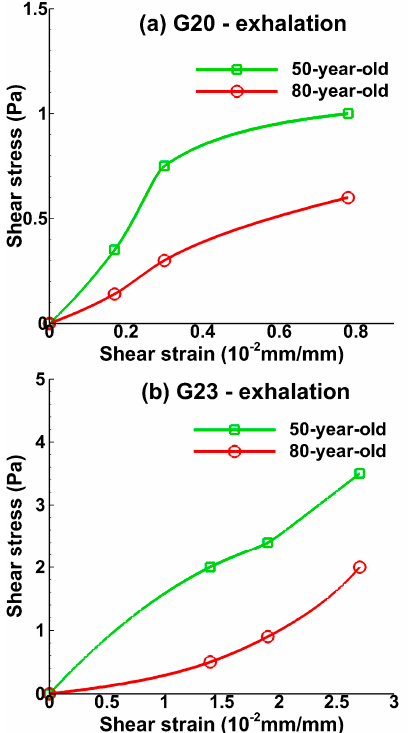
Figure 7. Relationship between shear strain and shear stress during mid ‐ point of exhalation (t = 1.2 s) at ( a ) the bronchiole (G20) and ( b ) the alveolar sac (G23) tissue for the 50 ‐ year ‐ old and 80 ‐ year ‐ old.